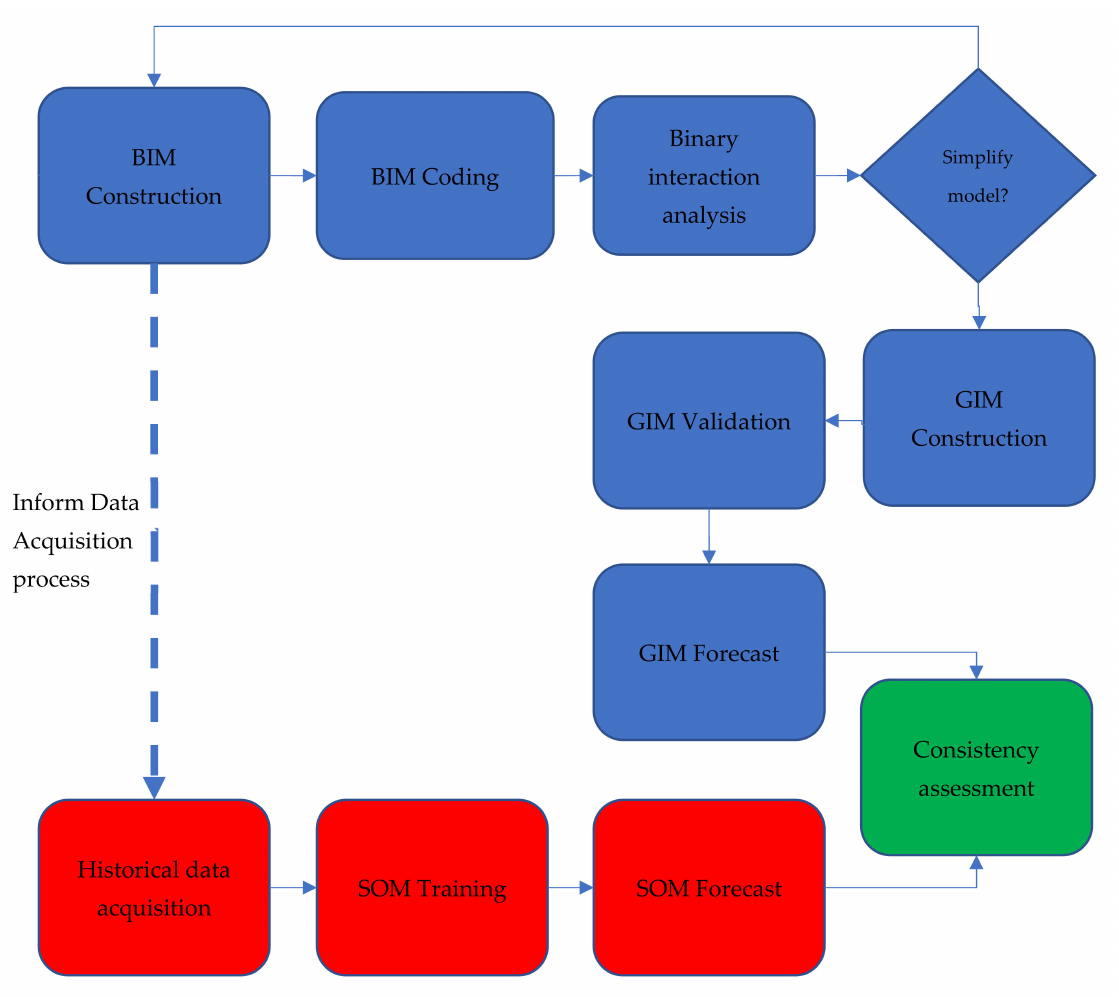
Figure 6. Proposed